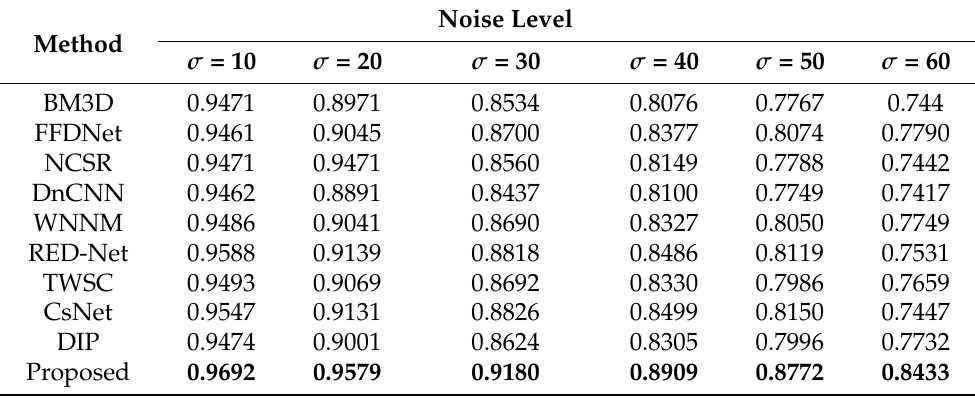
Table 16. Average SSIM results of different methods on 10 images in Urban100 with various noise levels.